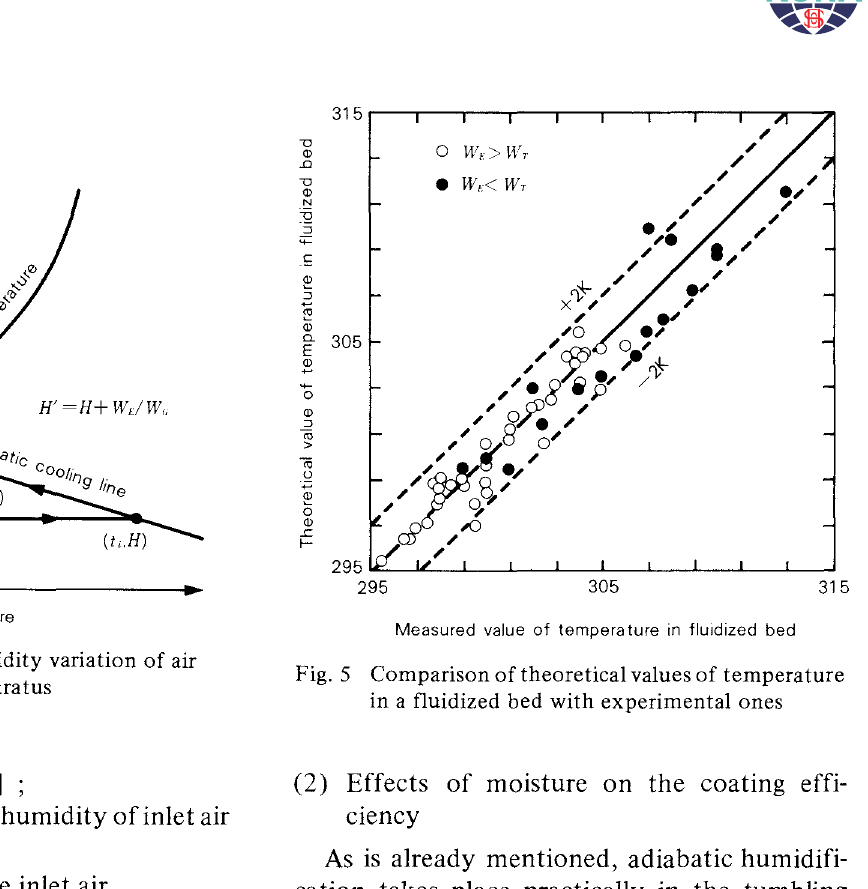
Fig. 5 Comparison of theoretical values of temperature in a fluidized bed with experimental